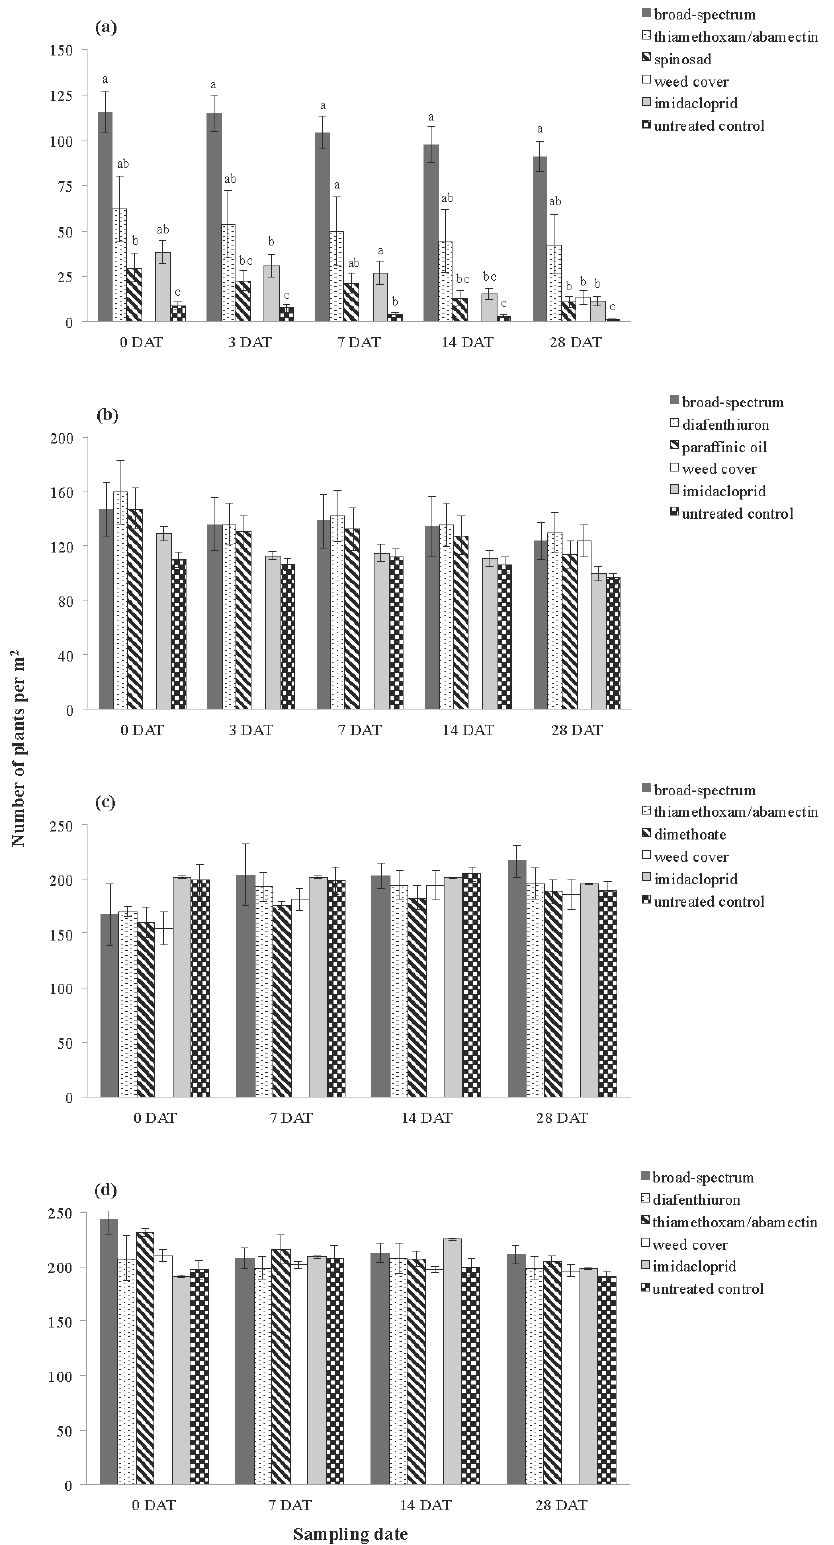
Figure 5. Average number of plants at ( a ) Inverleigh 2009, ( b ) Rossbridge 2009, ( c ) Inverleigh 2010 and ( d ) Rossbridge 2010. Plant counts were not scored for the Weed cover treatment at zero, three, seven and 14 DAT at Inverleigh 2009 and Rossbridge 2009. Error bars represent standard errors of the mean. Different letters above bars indicate significantly different means at each sampling date (at the p < 0.05 level, Tukey’s- b post hoc